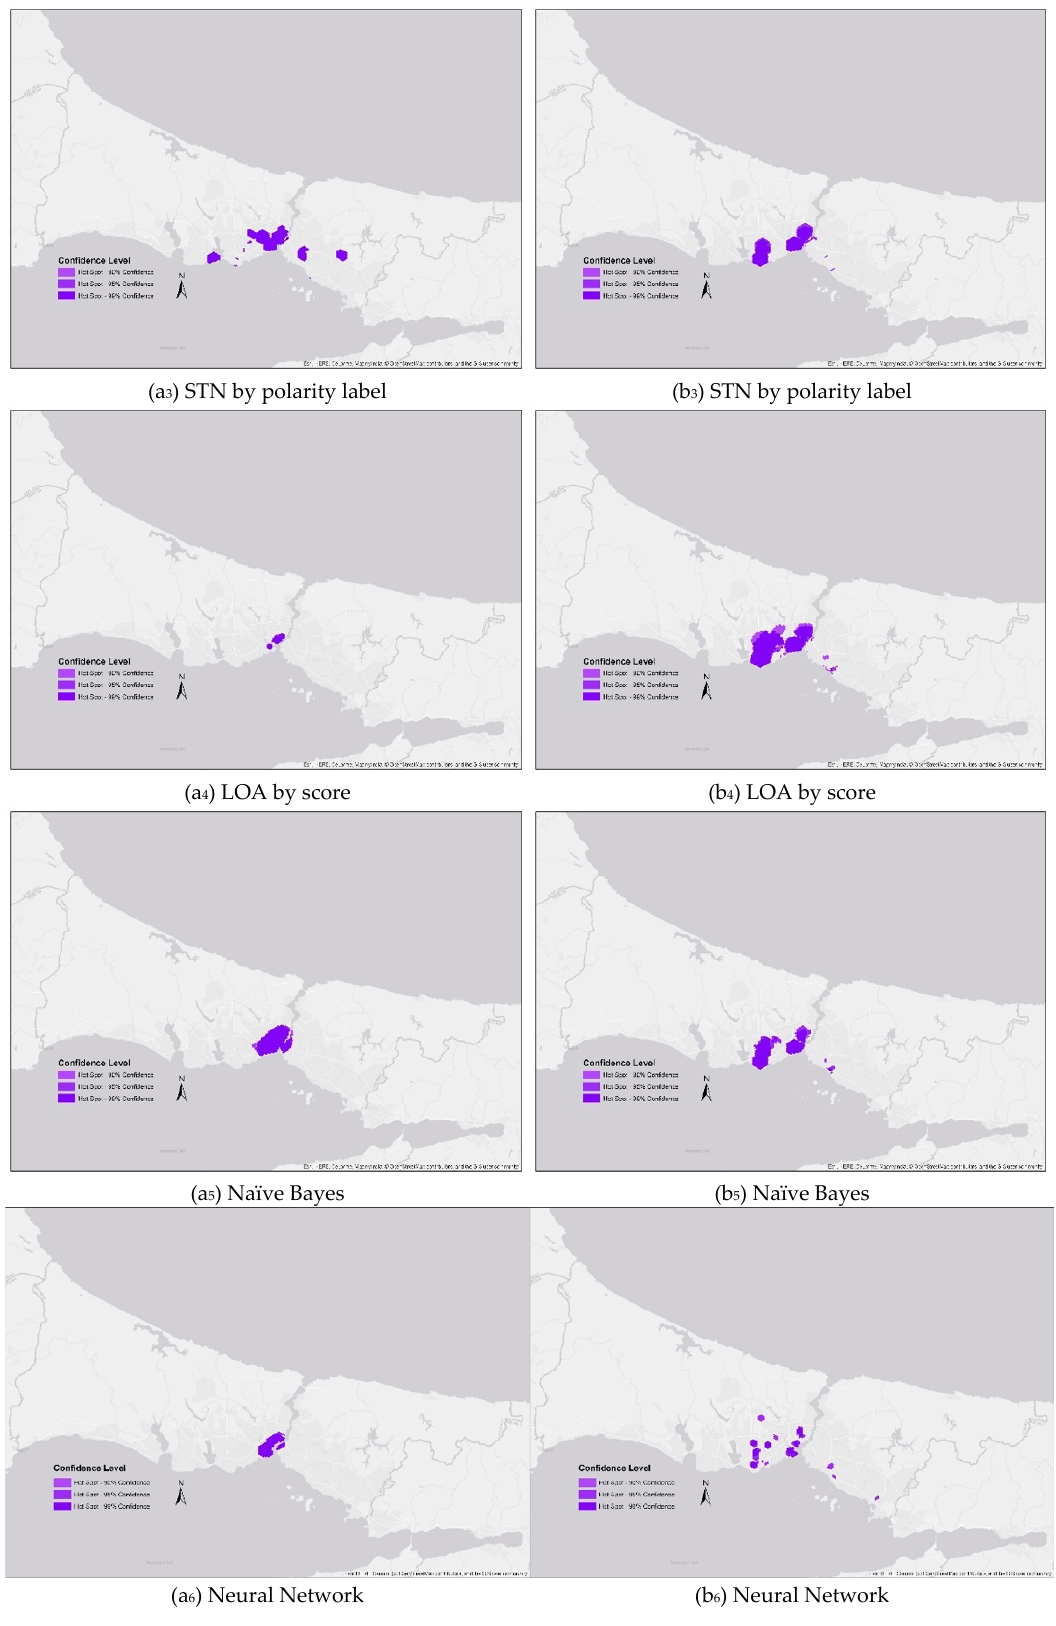
Figure 12. Optimized hotspots over previously filtered data. (a i ) BVA dataset; (b i ) ATA dataset.